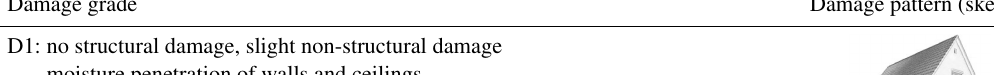
Table 1. Assignment of damage grades D i to damage cases: examples from the flood in August 2002 (after Schwarz and Maiwald, 2007). Damage